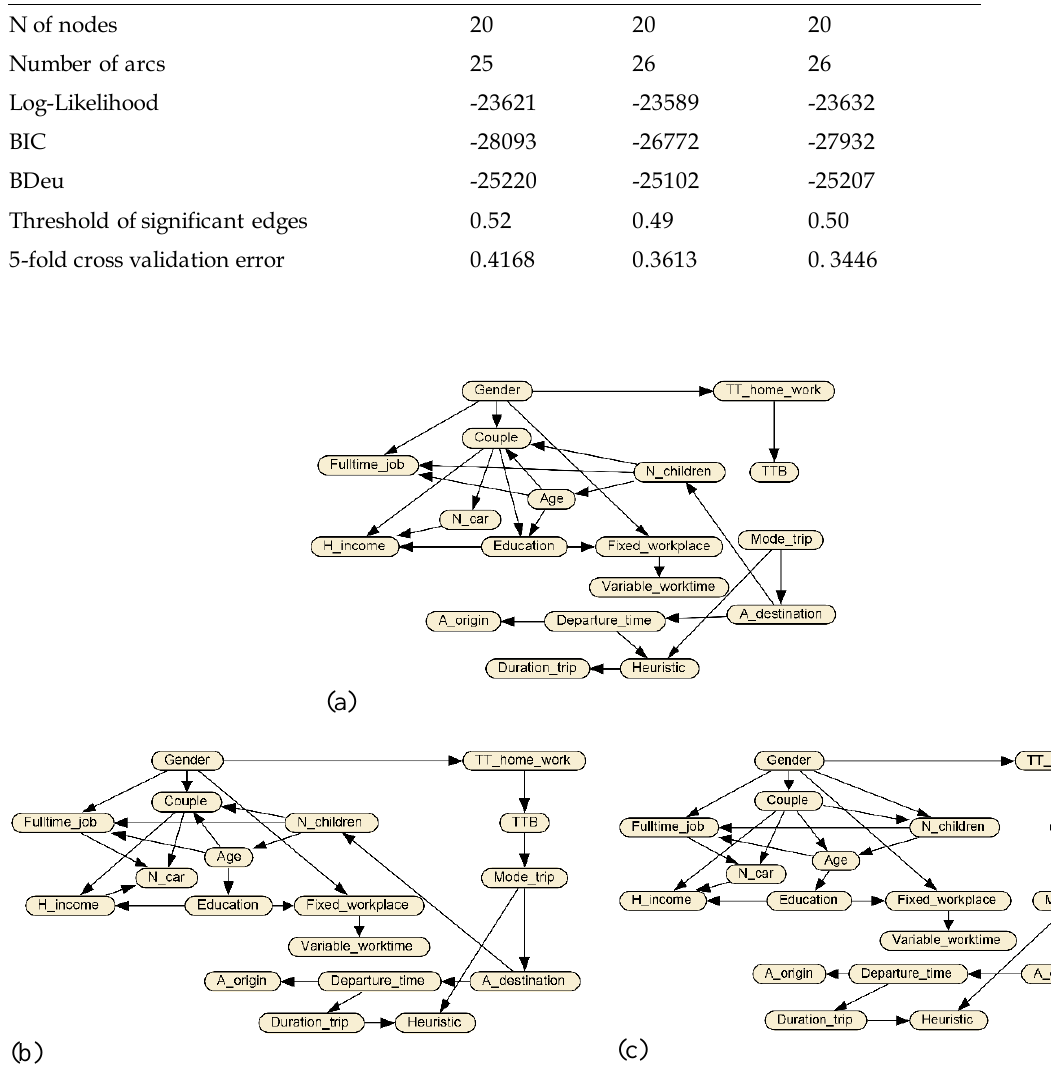
Figure 5. (a)Structure learning result without structural restrictions; (b) with Set 1 structural restrictions; (c) with Set 2 structural